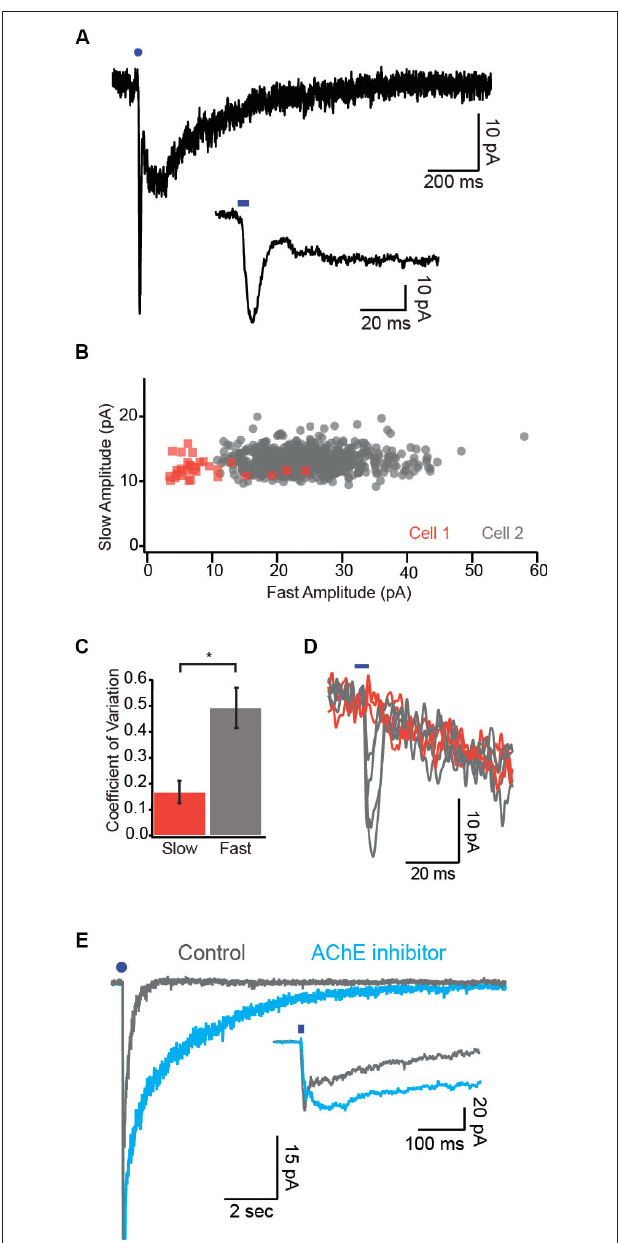
FIGURE 2 | Synaptic mechanisms underlying cholinergic transmission . (A) Example dual-component response recorded under voltage clamp. Note the fast α 7 mediated response followed by the slower non- α 7 response. Inset, fast component is displayed on an expanded timescale. (B) Response amplitude for the slow component is plotted against the response amplitude of the fast component for two cells. Note that the fast component exhibits much more variability in amplitude relative to the slow component. (C) Variability of the two response components quantified as the coefficient of variation (CV). (D) Example single trial responses to photostimulation demonstrate a reliable slow component across trials in which the fast component varied widely. Orange traces represent trials in which a fast component was not detectable. (E) Dual-component nicotinic responses before and after application of the AChE inhibitor ambenonium. Inset, expanded timescale reveals no effect of the AChE blocker on the fast component. Blue circles and ticks represent